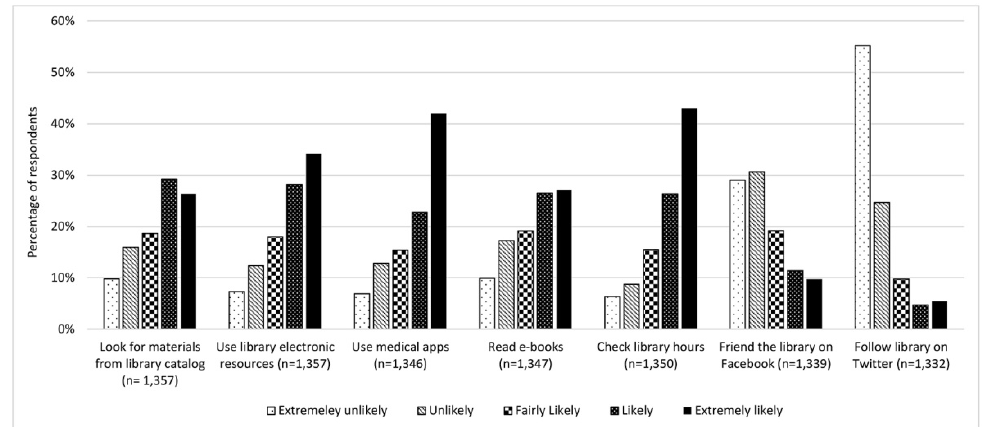
Figure 2 Likelihood of smartphone or tablet owners using library